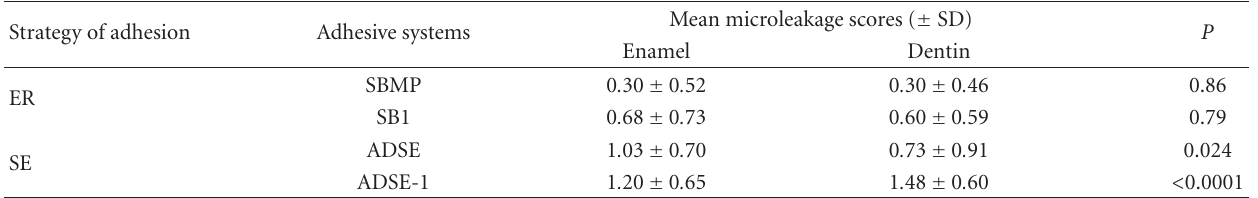
Figure 2: Pictures of the composite restoration before and after grooves’ preparation. Table 5: Mean microleakage scores of the tested adhesives at the enamel and dentin interfaces.